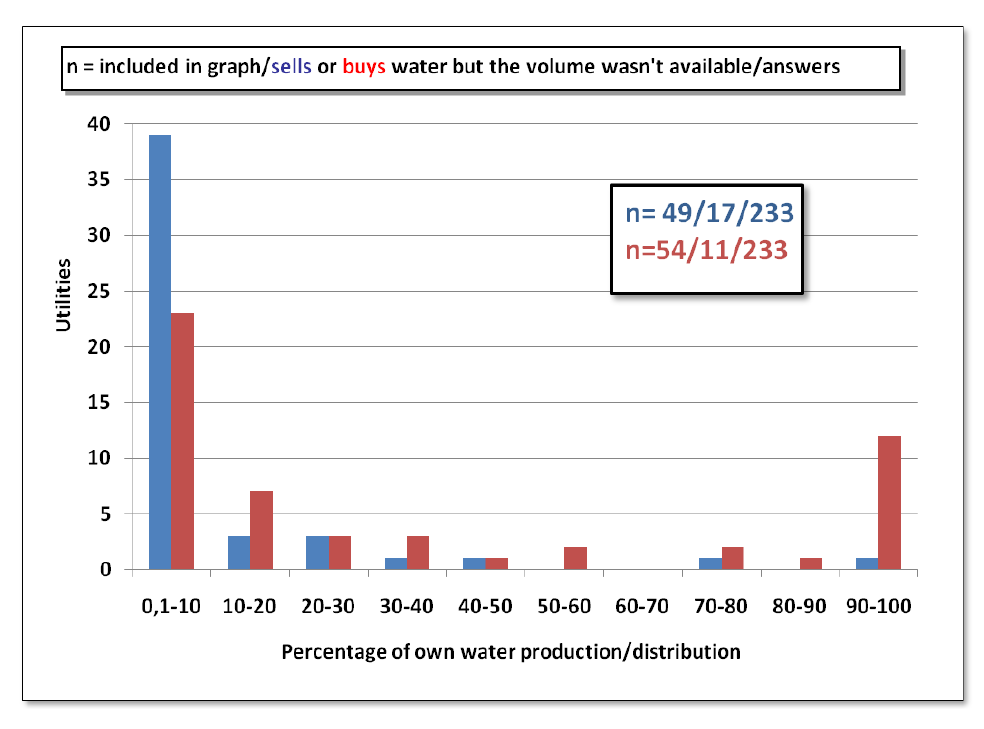
Figure 1. Percentage of water sold to or bought from other municipalities in 2006